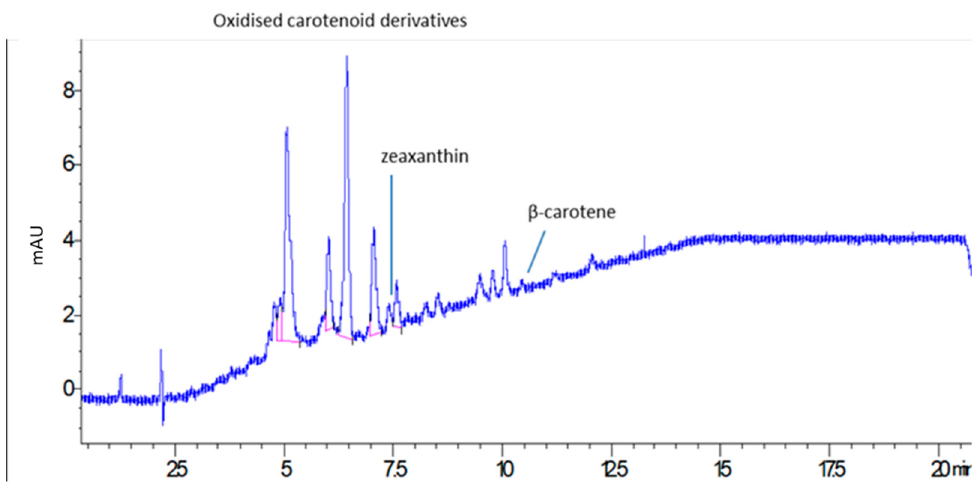
Figure 2. LC-DAD chromatogram related to the analysis of carotenoids and derivatives (425 nm). Table 2. Identified polar compounds in G. diversifolia extract by LC-DAD-ESI-MS, * indicate comparison with authentic standard.